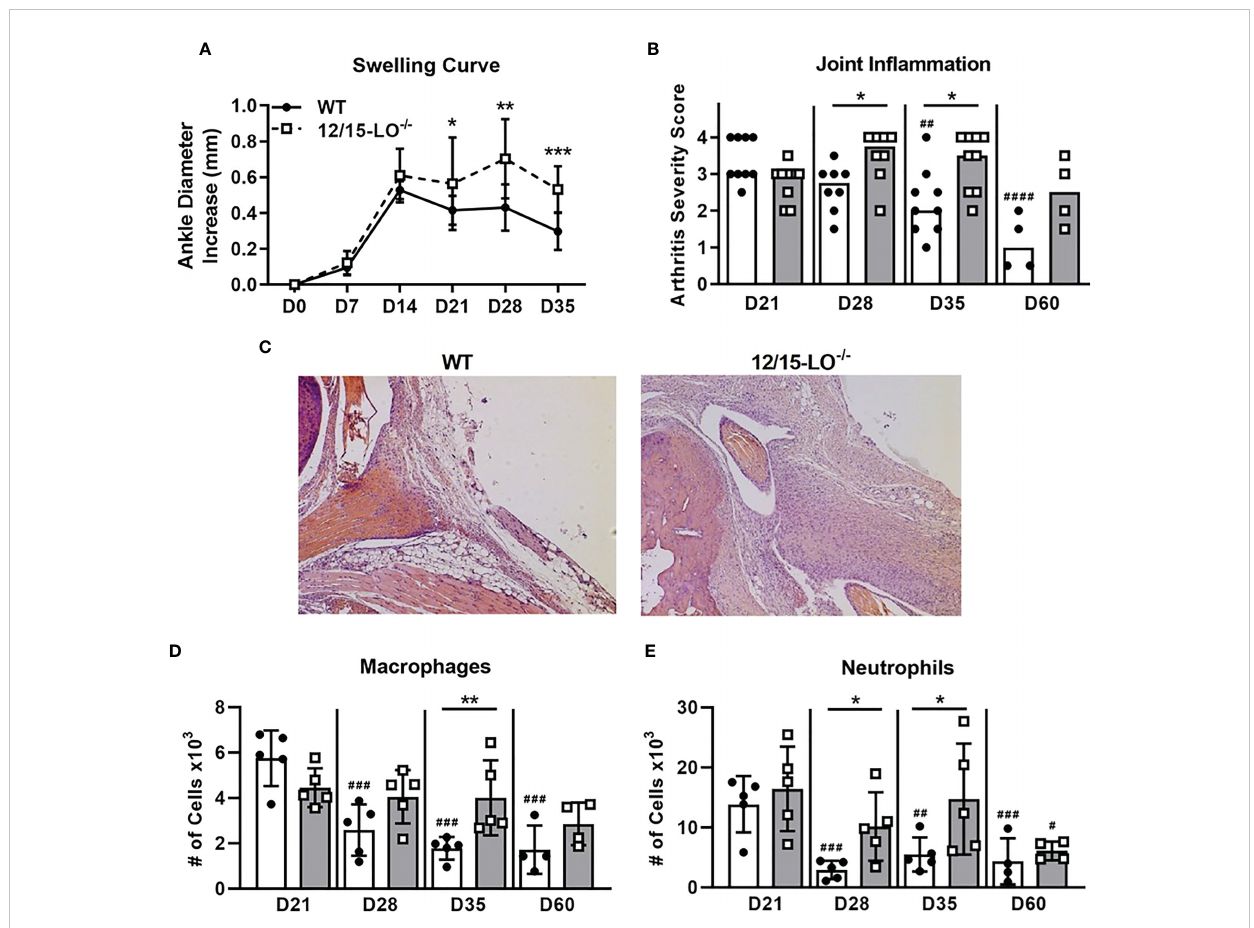
FIGURE 2 12/15-LO-/- C3H mice display defective mLA resolution. C3H WT and 12/15-LO-/- mice were infected with B burgdorferi and mLA was followed over time. (A) Ankle swelling curve throughout mLA displayed as diameter change from D0 (uninfected). Closed circles and solid line represent WT mice and open squares and dotted line represent 12/15-LO-/- mice. n=10/group. *p<0.05, **p<0.01, ***p<0.001 by t-test between strains per timepoint. ## p<0.01, #### p<0.0001 by Kruskal-Wallis one-way ANOVA with Dunnett ’ s test compared to D21 of the respective strain. (B) Arthritis severity scores as determined by histological analysis of H&E-stained ankle joints (scale 0-4) from mice sacri fi ced on the indicated days. Closed circles represent WT and open squares represent 12/15-LO-/- individual animals. Open bars represent median values from WT mice and grey bars represent 12/15-LO-/- mice. n=4-9/group. Data from two experiments were combined to increase the n value for D21, D28, and D35 groups. *p<0.05 Mann-Whitney U test. (C) Representative histology from WT and 12/15-LO-/- ankles at D35. Ankle joints were isolated and (D) macrophage (CD45.2+F4/80+) and (E) neutrophil (CD45.2+Ly-6Ghi) populations were quanti fi ed by fl ow cytometry. n=4-5/group. *p<0.05, **p<0.01 by t-test between strains per timepoint. # p<0.05, ## p<0.01, ### p<0.001 by one-way ANOVA with Dunnett ’ s test compared to D21 of the respective